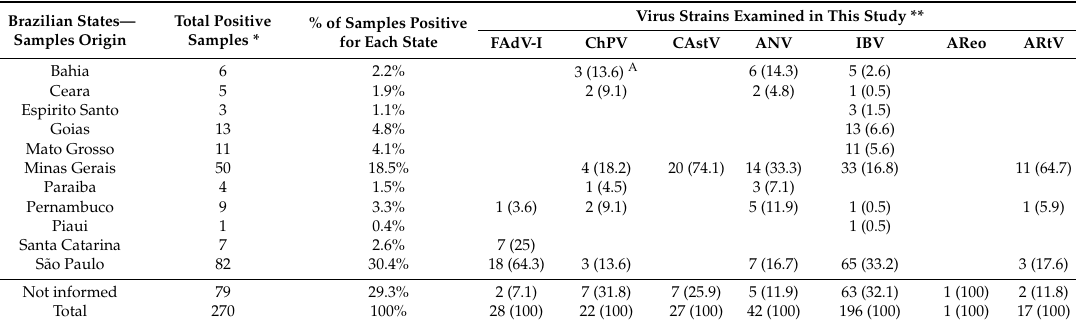
Virus Strains Examined in This Study